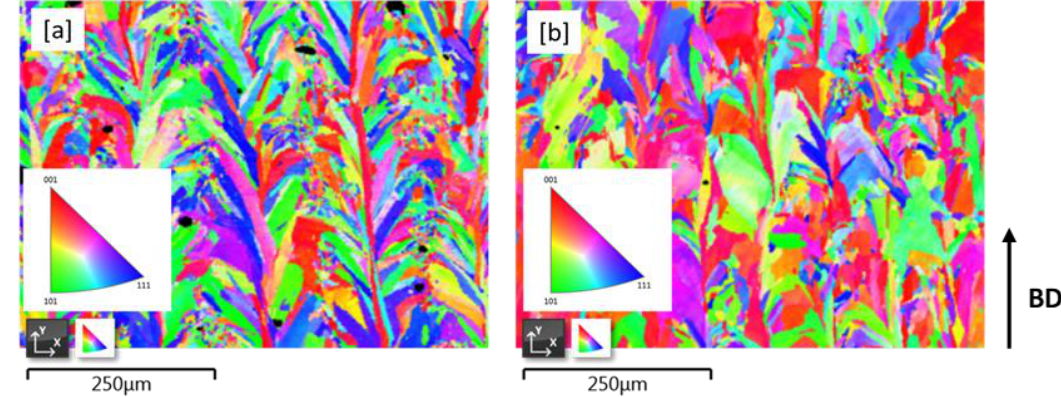
Figure 8. Inverse pole figures of as-built samples: ( a ) 80 µm hatch distance; ( b ) 140 µm hatch distance showing columnar orientation along the building direction.